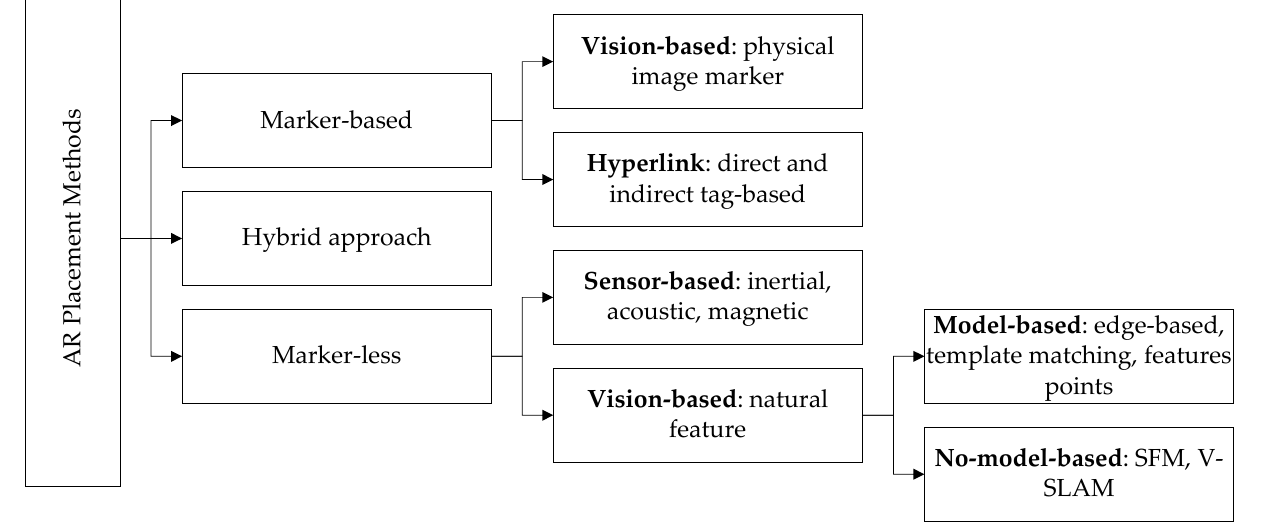
Figure 1. Taxonomy of AR placement methods.